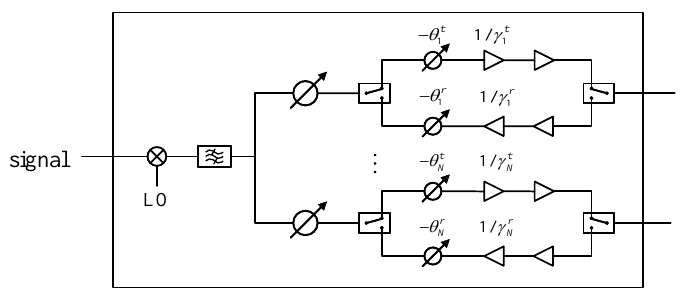
Figure 3. Modified Tx/Rx Module for transmitting and receiving